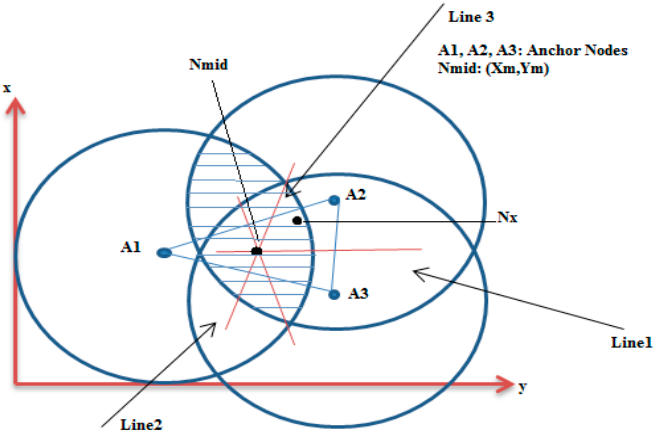
Figure 3. Mid-perpendicular using an acute triangle.